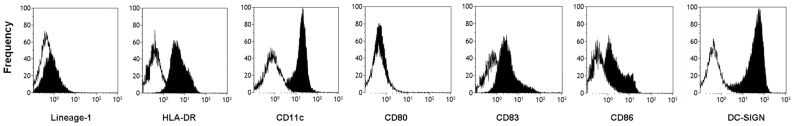
Phenotypic analysis of monocyte-derived immature dendritic cells.Expression profile of different cell type markers by flow cytometry, details are provided in the text. One representative analysis is shown. White curve area: control antibody. Black curve area: specific staining antibody.